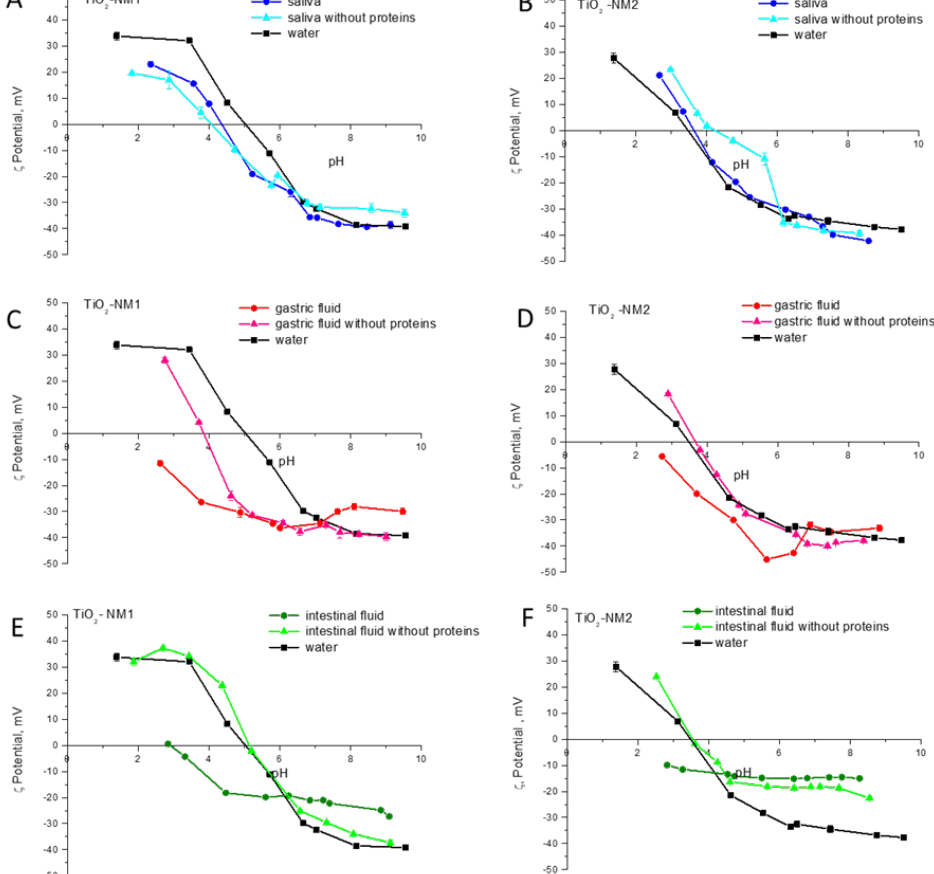
Figure 7. E ff ect of the hard-biocorona on the ζ -potential of the nanometric TiO 2 samples. ζ -potential vs. pH measured in water of the pristine samples and of the samples treated in saliva, gastric and duodenal with and without proteins and washed to remove molecules weakly adsorbed. ( A , C , E ): TiO 2 -NM1; ( B , D , F ): TiO 2 -NM1.